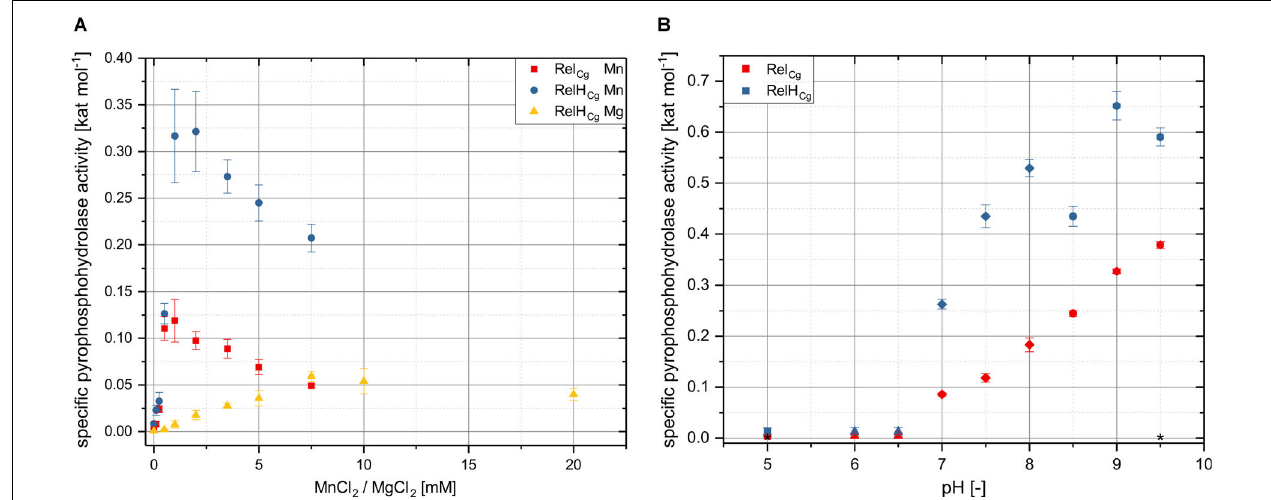
FIGURE 4 | In vitro characterization of Rel Cg and RelH Cg with respect to divalent ion concentration and pH. The specific pyrophosphohydrolase activities of the purified enzymes were determined by (pp)pGpp pyrophosphohydrolase assays and subsequent HPLC analysis (see Material and Methods) under variation of MgCl 2 /MnCl 2 concentration (A) and pH-value (B) . The reaction mixture for determining the dependence on divalent ions contained 50 mM HEPES-Na (pH 8.0), 200 mM NaCl, 0.5 mM ppGpp as well as 52.3 nM RelH Cg or 98.2 nM Rel Cg respectively, and was incubated at 30 ◦ C. In order to avoid oxidation of Mn 2 + , the corresponding solutions were saturated with nitrogen before the addition of substrates and enzyme to remove dissolved oxygen. The incubation time was 25 min for RelH Cg and 45 min for Rel Cg containing approaches. Since comparatively low activities were measured using magnesium, 10 times higher enzyme concentrations were used. The pH dependency was determined with identical reaction components and experimental parameters, whereby different buffer systems and a defined MnCl 2 concentration of 1 mM were used. The various buffer systems (50 mM each) are illustrated by different icons: square: citrate buffer; triangle: phosphate buffer; rhombus: HEPES-buffer; circle: TRIS buffer; hexagon: ammonia buffer. Mean values and standard deviations shown were calculated from three replicates. ∗ Enzyme free controls were carried out at the highest and lowest pH values of 5 and 9.5 and did not yield any unspecific production of GDP or other components, so that the substrate ppGpp is considered to be stable at the pH conditions used.